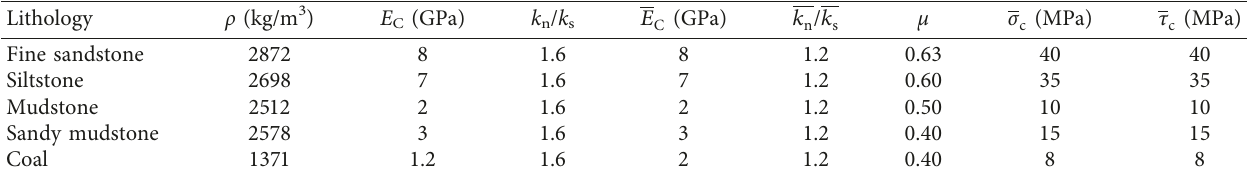
Figure 9: Calibration procedure defined by Itasca Table 2: Mechanical parameters of rock mass.